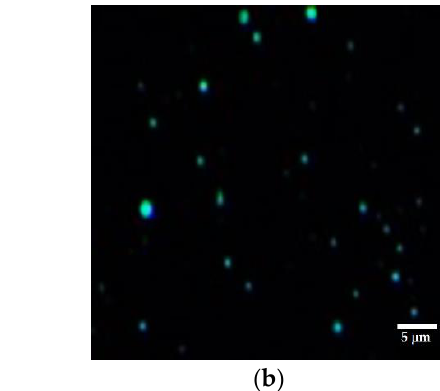
Figure 2. Representative particle diameter distributions of OL nanocapsules and Catalyst I – IV .